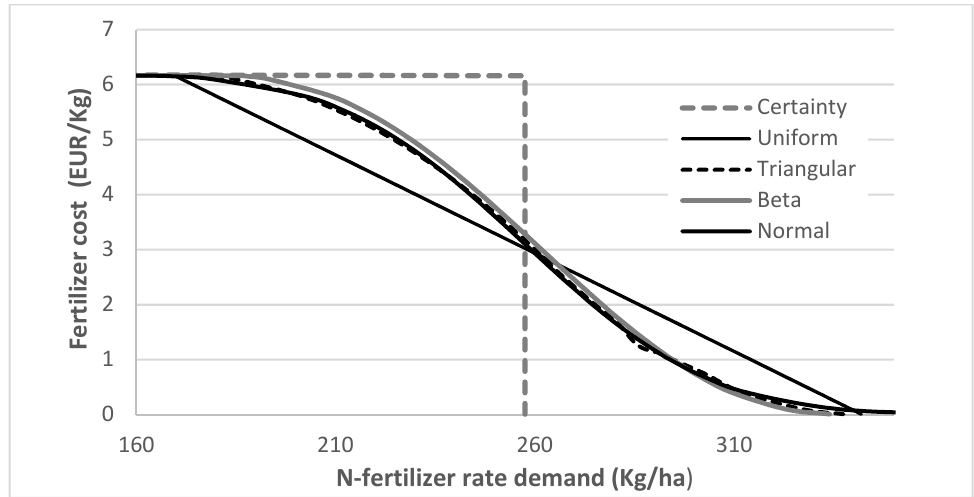
Figure 3. Fertilizer demand for stochastic yield distribution (crop price 0.2 EUR/kg − 1 ; Average yield = 12,441 kg·ha − 1 ).